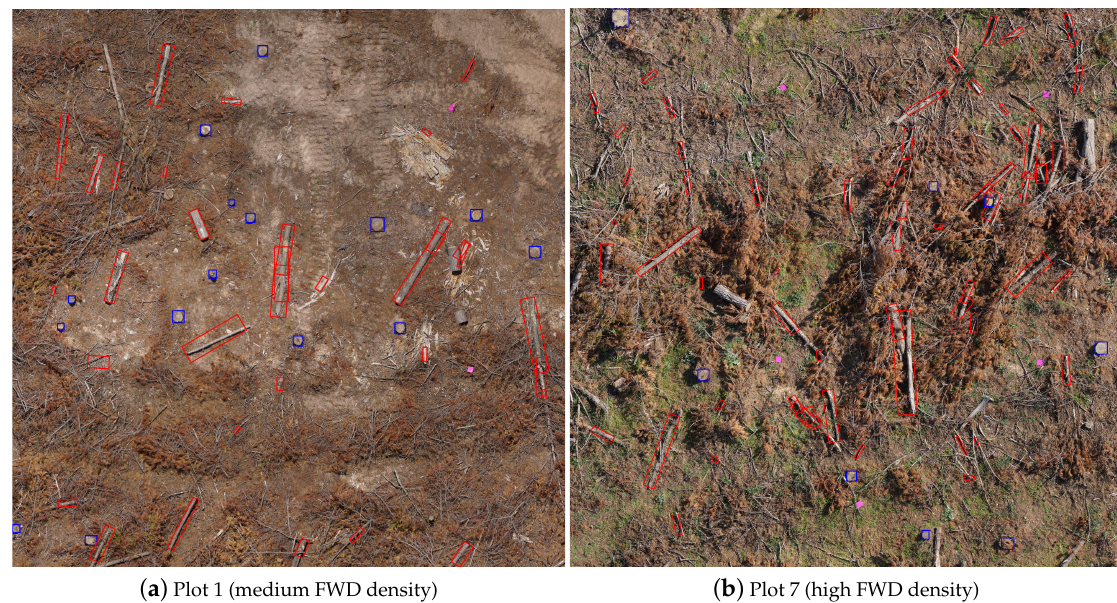
Figure 9. Stump detection and CWD rectangle fitting results from fold number five on selected plots (( a ) plot 1 and ( b ) plot 7) with varying densities of FWD. The results are using large bounding box annotations to train the R-CNN object detector and a stride S detect of 200 pixels. The logs are fitted with red rectangles and the stump detections are shown with blue boxes. The rectangles have not had their diameters scaled. Table 5. Autonomous CWD detection results for each plot, averaged over cross-validation folds. Three different methods for detection are compared. The top precision and recall scores for each plot are highlighted in bold. Small Boxes, Stride 100 Large Boxes, Stride 100 Large Boxes, Stride 200 Plot No. Precision Recall Precision Recall Precision Recall 0 0.178 ±